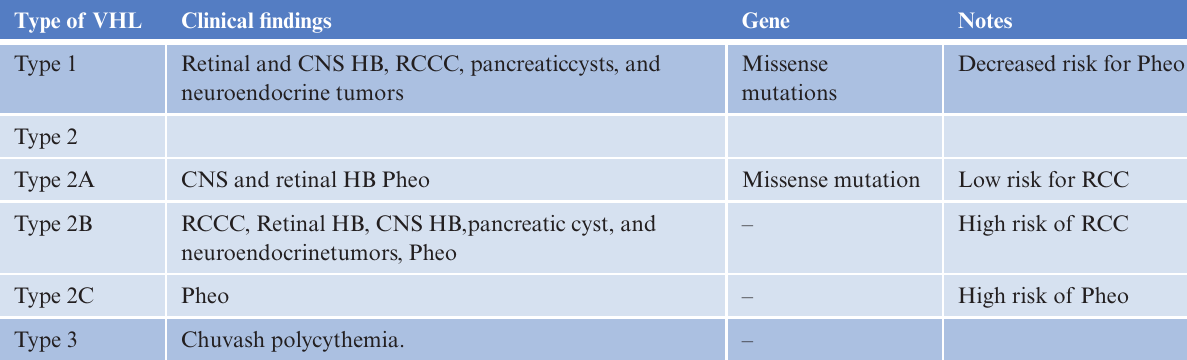
Table 2: Type of VHL, clinical findings, gene mutations, and notes. Type of VHL Clinical